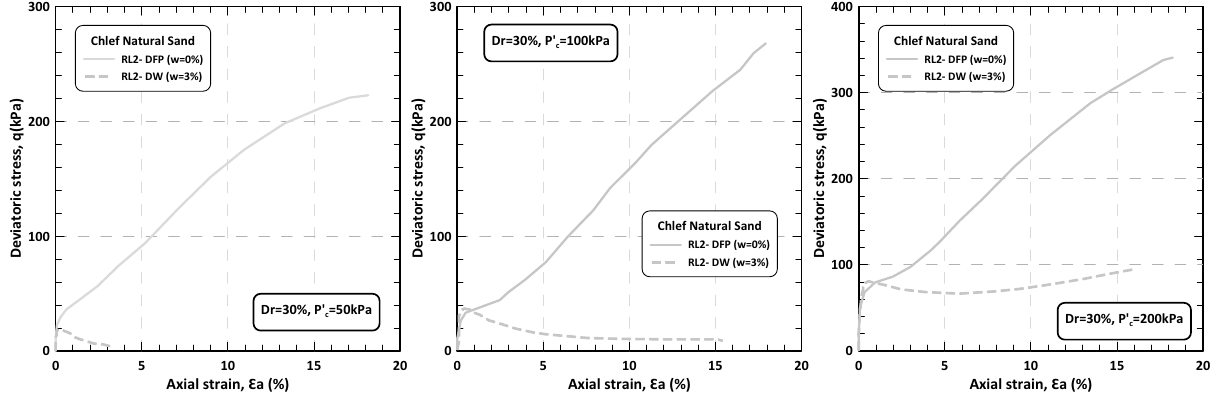
Fig. 9 Deviator stress versus axial strain curves of sand samples reinforced with two layers of geotextile under different confining pressures: a p ′ = 50 kPa, b p ′ = 100 kPa, and c p ′ = 200 c c c